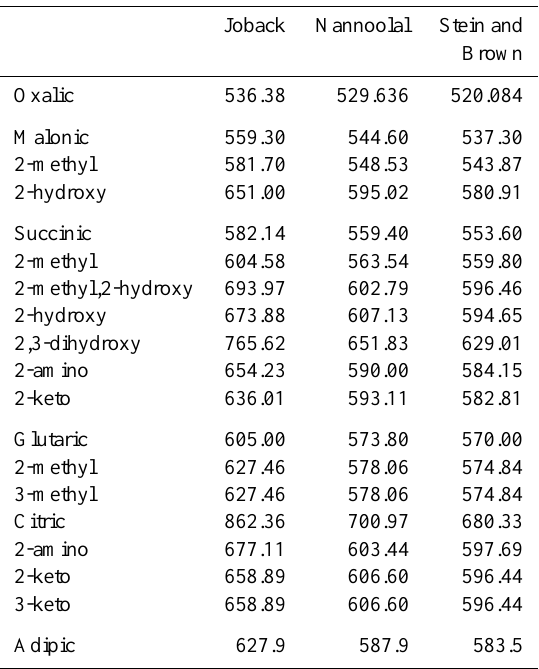
Table 6. Normal boiling points by the estimation methods, in K.